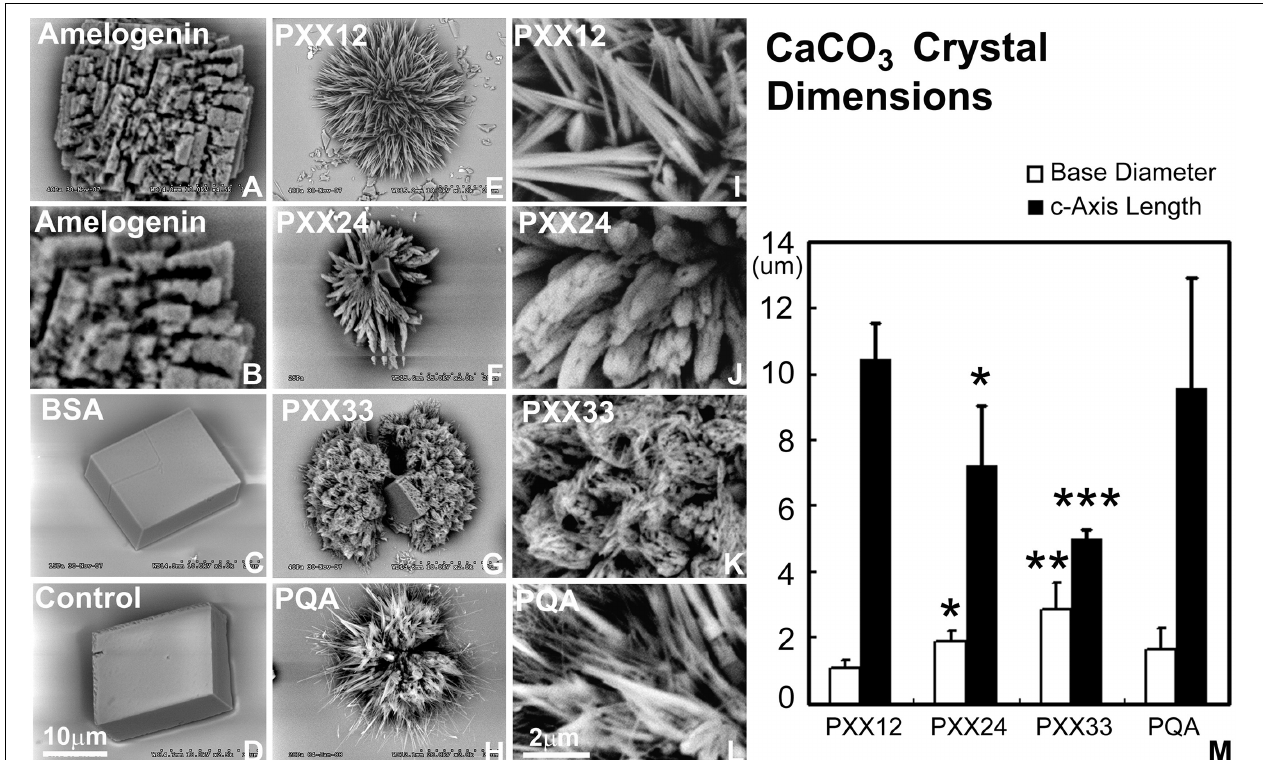
FIGURE 3 | Effect of polyproline repeat fragments of varying length on calcium carbonate crystal growth. Scanning electron micrographs shown here document the outcomes of calcium carbonate crystal growth studies in the presence of polyproline repeat fragments of varying lengths. (A,B) are calcium carbonate crystals grown in the presence of amelogenin, (C) using bovine serum albumin as a protein control, and (D) is without protein. In (E – G) , polyproline repeat peptides of varying length from 12 to 33mer were